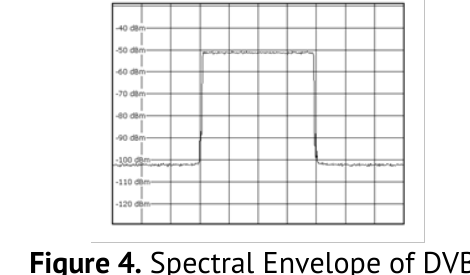
Figure 3. DVB-T2 time waveform.